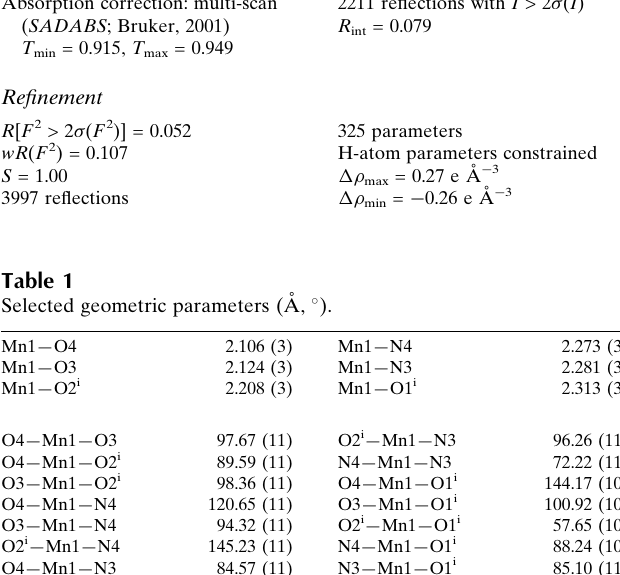
Bruker APEXII CCD area-detector diffractometer